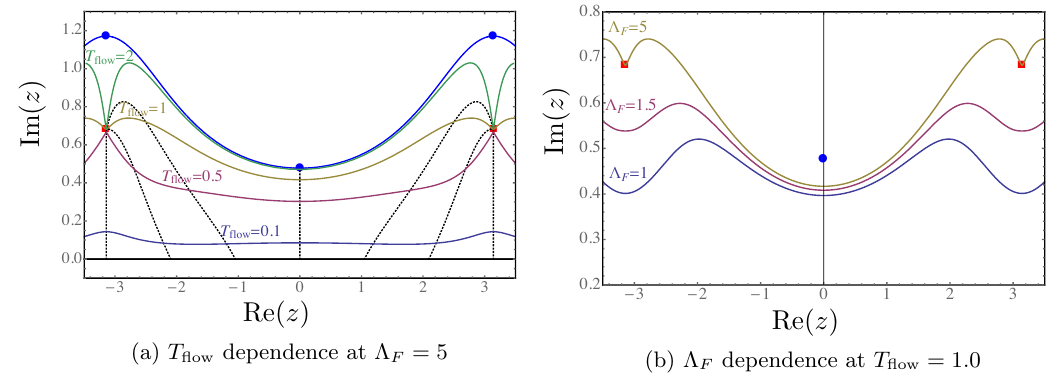
Figure 8 . Complex contours J (cid:3) ( T (cid:13)ow ) for the U(1) one-link model with (cid:20) = 1 = 2. We set (cid:3) B = 5. The saddle points are denoted by the blue dots while the zeros of the fermion determinant are depicted as red squares. The dashed curves in the left (cid:12)gure are (cid:13)ow lines which end at a zero of the fermion determinant or at the saddle point on the imaginary axis which is intersected by the Lefschetz thimble.